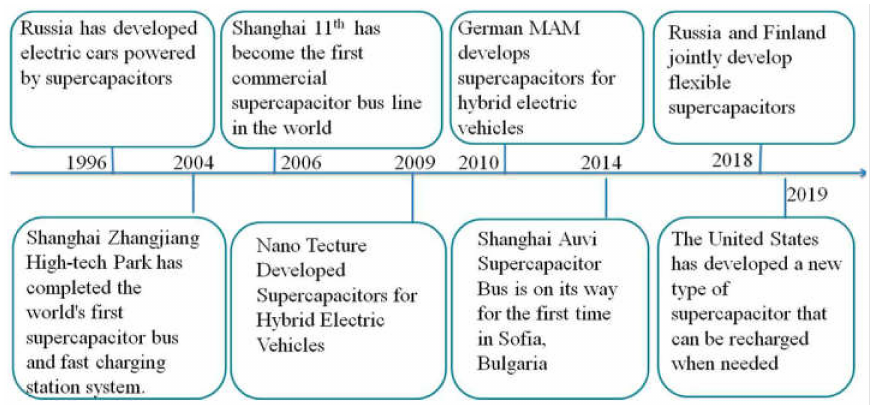
Figure 2. The development of supercapacitors in different countries. Reproduced with permission from [36]. AIP Publishing LLC,